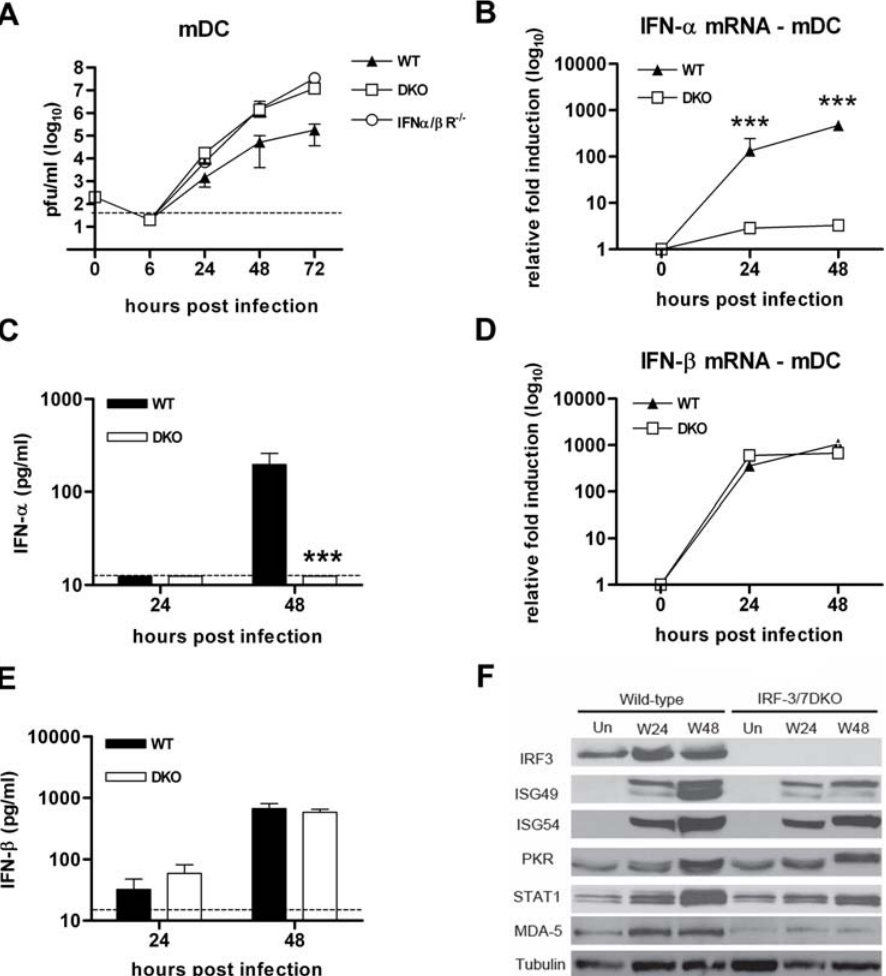
Figure 6. The WNV-induced IFN- b response and ISG expression is primarily IRF-3 and IRF-7-independent in mDC. A . mDC generated from wild type, IFN- ab R 2 / 2 and DKO mice were infected at an MOI of 0.001 and virus production was evaluated at the indicated times post infection by plaque assay. Values are an average of quadruplicate samples generated from at least three independent experiments (***, P , 0.0001). B–E . Levels of ( B ) IFN- a and ( D ) IFN- b mRNA as well as ( C ) IFN- a and ( E ) IFN- b protein in WNV-infected mDC were measured by qRT-PCR or ELISA as described in the legend of Figure 3. F . Whole cell lysates were generated at the indicated times from wild type and DKO mDC that were uninfected (Un) or infected with WNV (W). Protein levels of ISG49, ISG54, PKR, STAT1, RIG-I, MDA5 and tubulin were examined by immunoblot